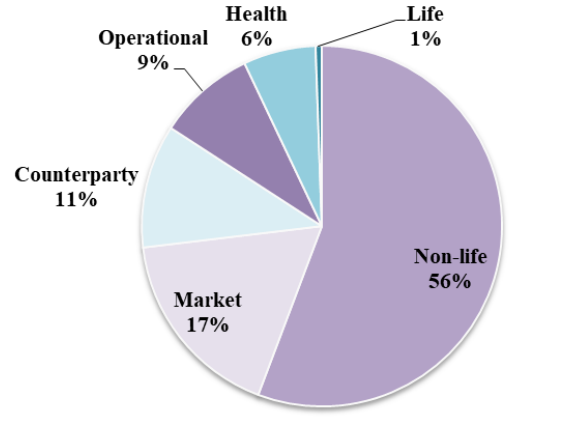
Fig. 3. Median risk profile.